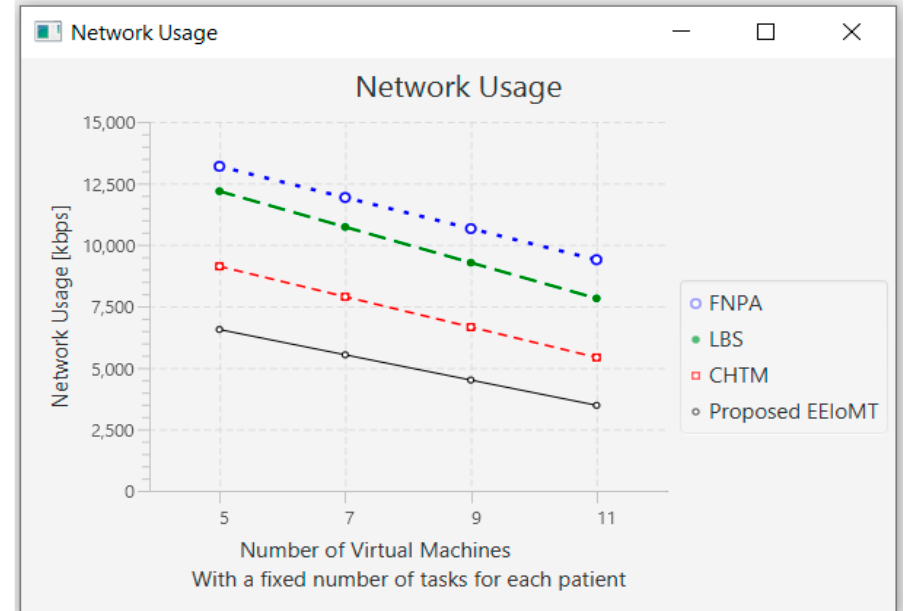
Figure 18. Network usage comparison when changing the number of VMs.